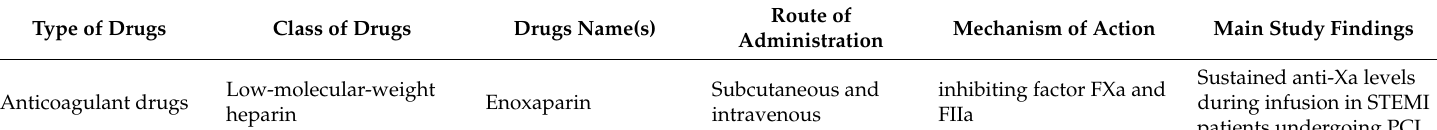
Table 1. Of novel antithrombotic drugs tested in clinical